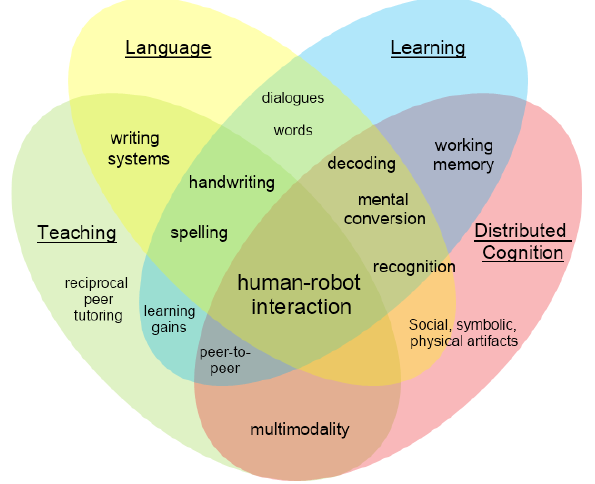
Figure 5. Visual representation of the theoretical framework for